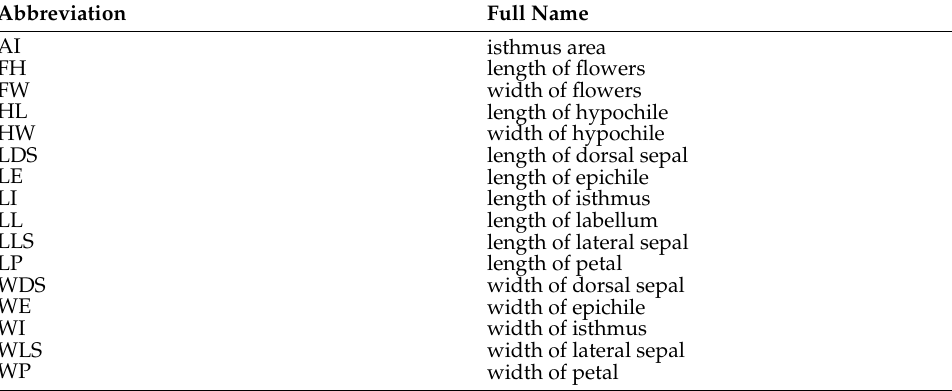
Table 4. Measured flower structure